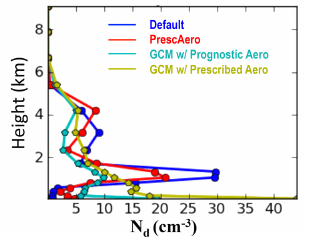
Figure 10. Profiles of in-cloud droplet number concentrations ( N d ) during the ARM95 IOP period. GCM data are July averages over the 10 simulated years extracted at the location of